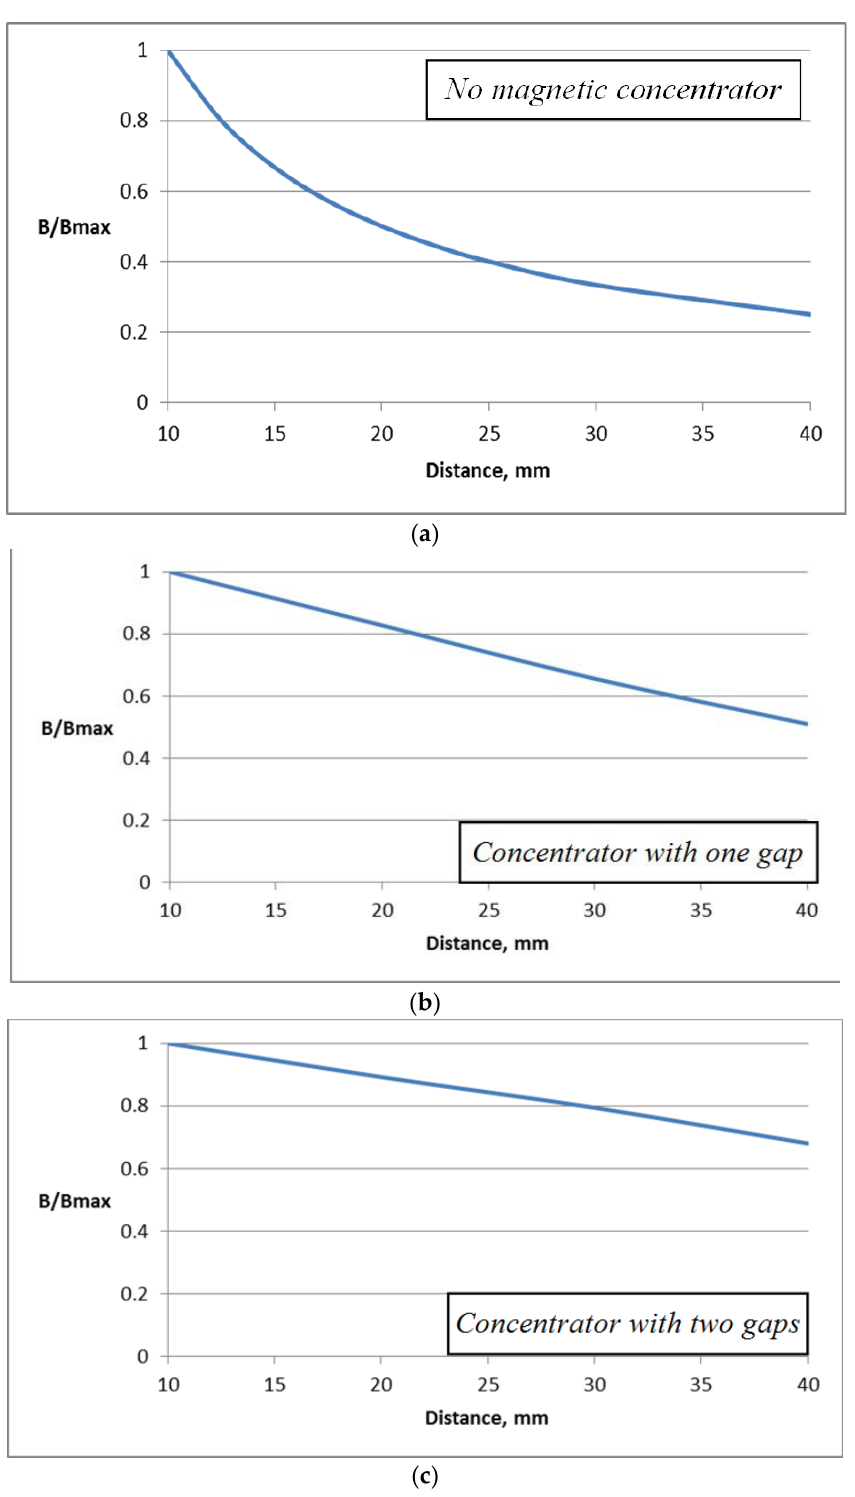
Figure 5. Dependence of the flux density on the distance to the conductor ( a ) no magnetic concentrator; ( b ) concentrator with one gap; ( c ) concentrator with two gaps.